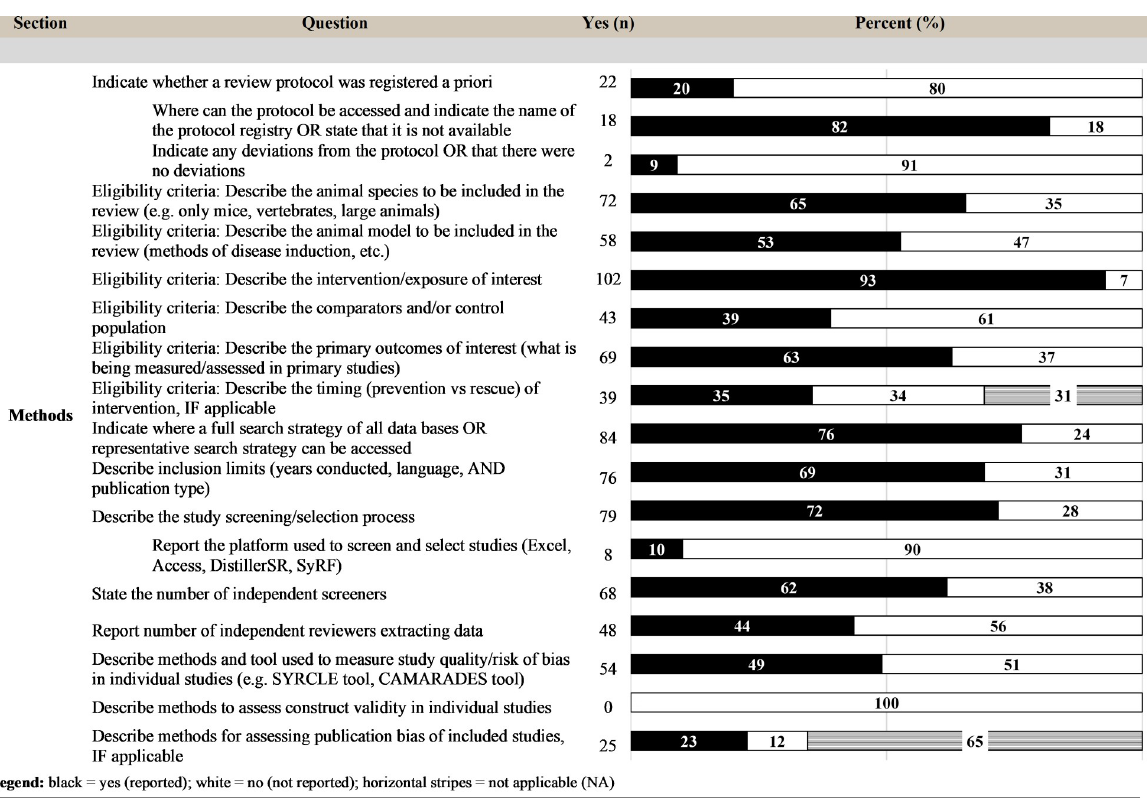
Fig 6. Level of reporting (count and percent) for the items within the methods section. CAMARADES, Collaborative Approach to Meta- Analysis and Review of Animal Data from Experimental Studies; DistillerSR, Distiller Systematic Review Software; SYRCLE, SYstematic Review Center for Laboratory animal Experimentation.